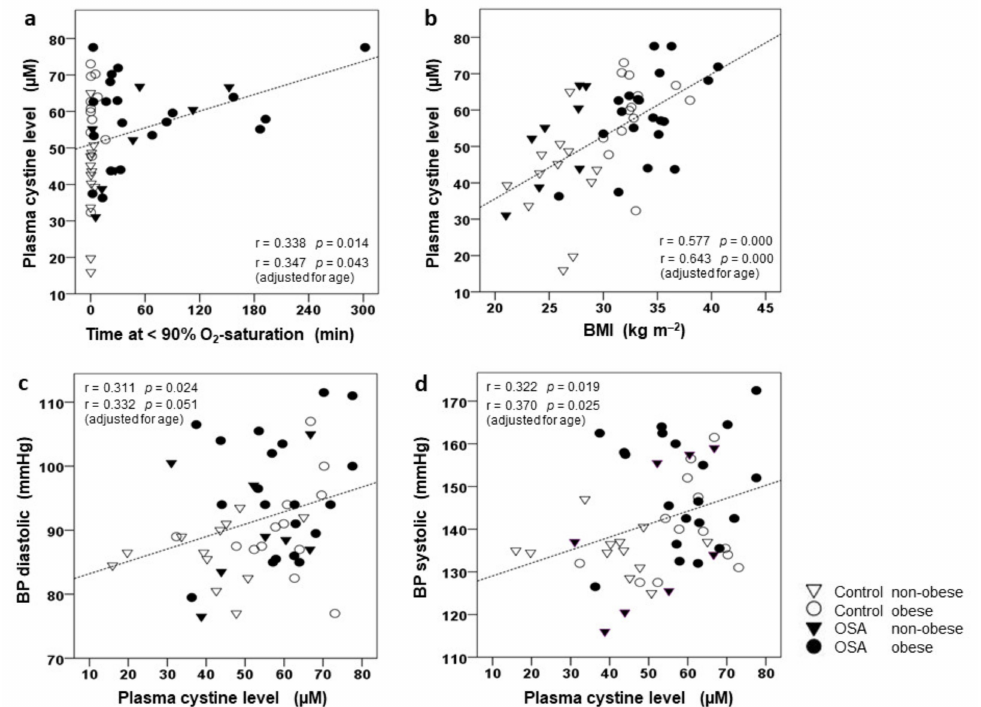
Figure 3. Correlation of plasma cystine (CySS) concentration to cumulative time spent at O 2 -saturation < 90% (Tu90%) ( a ) and to BMI ( b ) as well as correlation between diastolic ( c ) and systolic ( d ) brachial blood pressure (BP) and plasma CySS concentration. Graphs present scatterplots of individual values with indications of groups (OSA, control) and their strata (non-obese, obese), the regression lines as well as regression coefficients r and p -values. In addition, r and p -values are given for (multivariate) correlation adjusting for